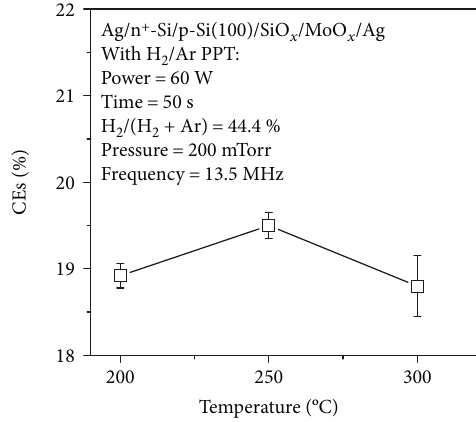
Figure 4: CEs vs. temperature curves of the SPSSCs. The treated parameters were addressed at 60 W for 50 s and H 2 / ð H 2 + Ar Þ of 44.4%.